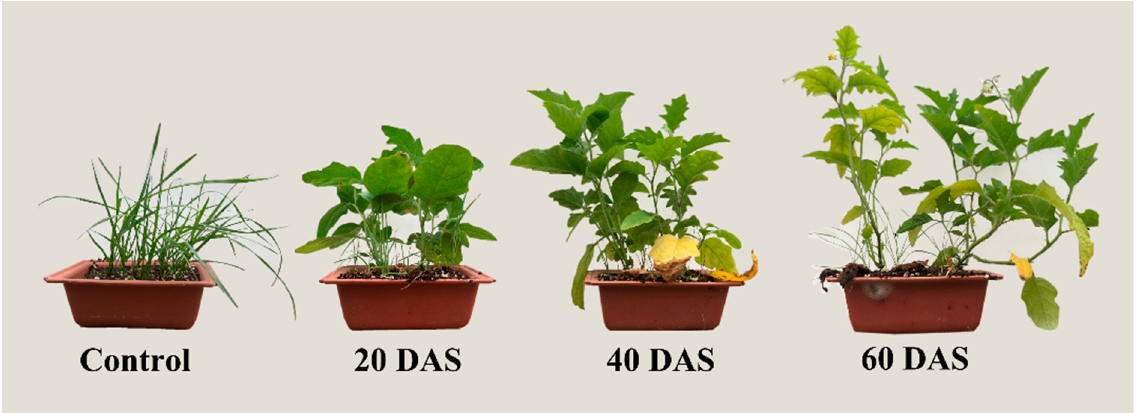
Table 2. Effect of Solanum carolinense dominance on the growth of Festuca arundinacea at different time intervals.